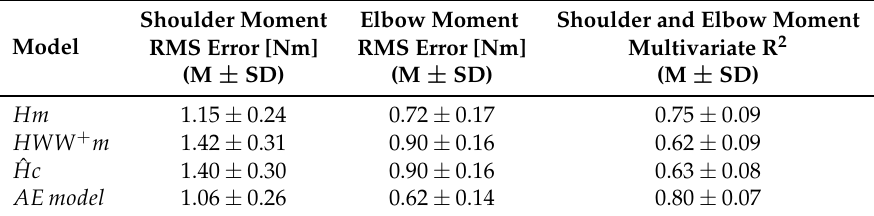
Table 1. Means and standard deviations of the shoulder/elbow moment RMS errors and Multivariate R 2 index values among all